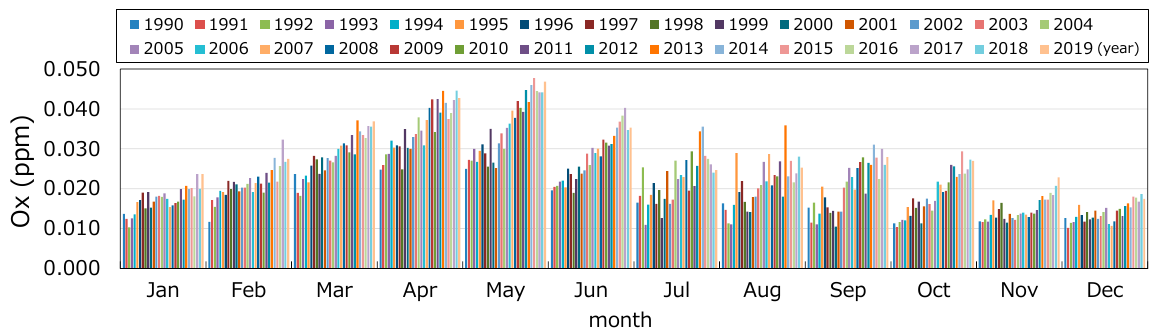
Figure 4. Trend in monthly average Ox for each month. Ox: monthly averages of hourly Ox at all nine General sta.